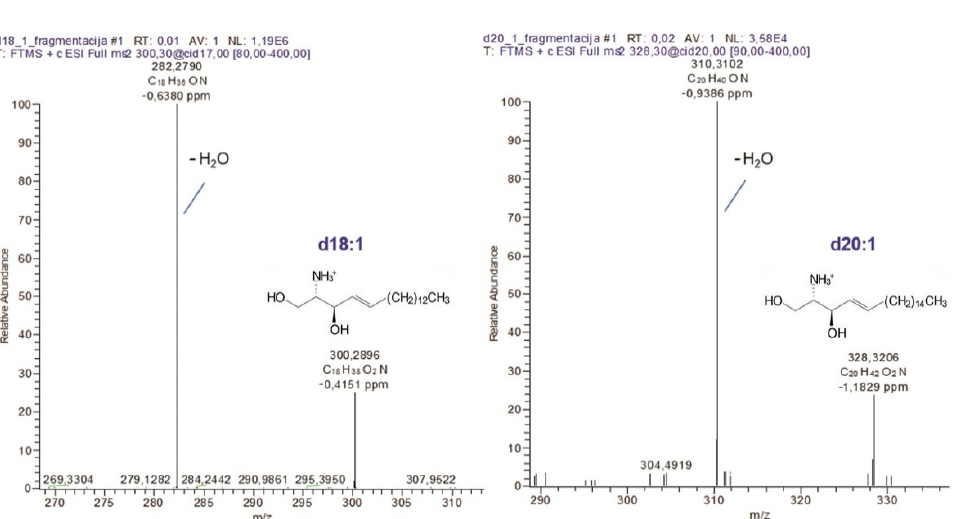
Figure 5. Fragmentation spectra obtained via CID MS 2 of the [M-2H + ] 2 − ion at m/z 952.50 confirming the GD1b (d18:1/23:0) structure in the ganglioside mixture from anaplastic ganglioglioma tumor tissue.